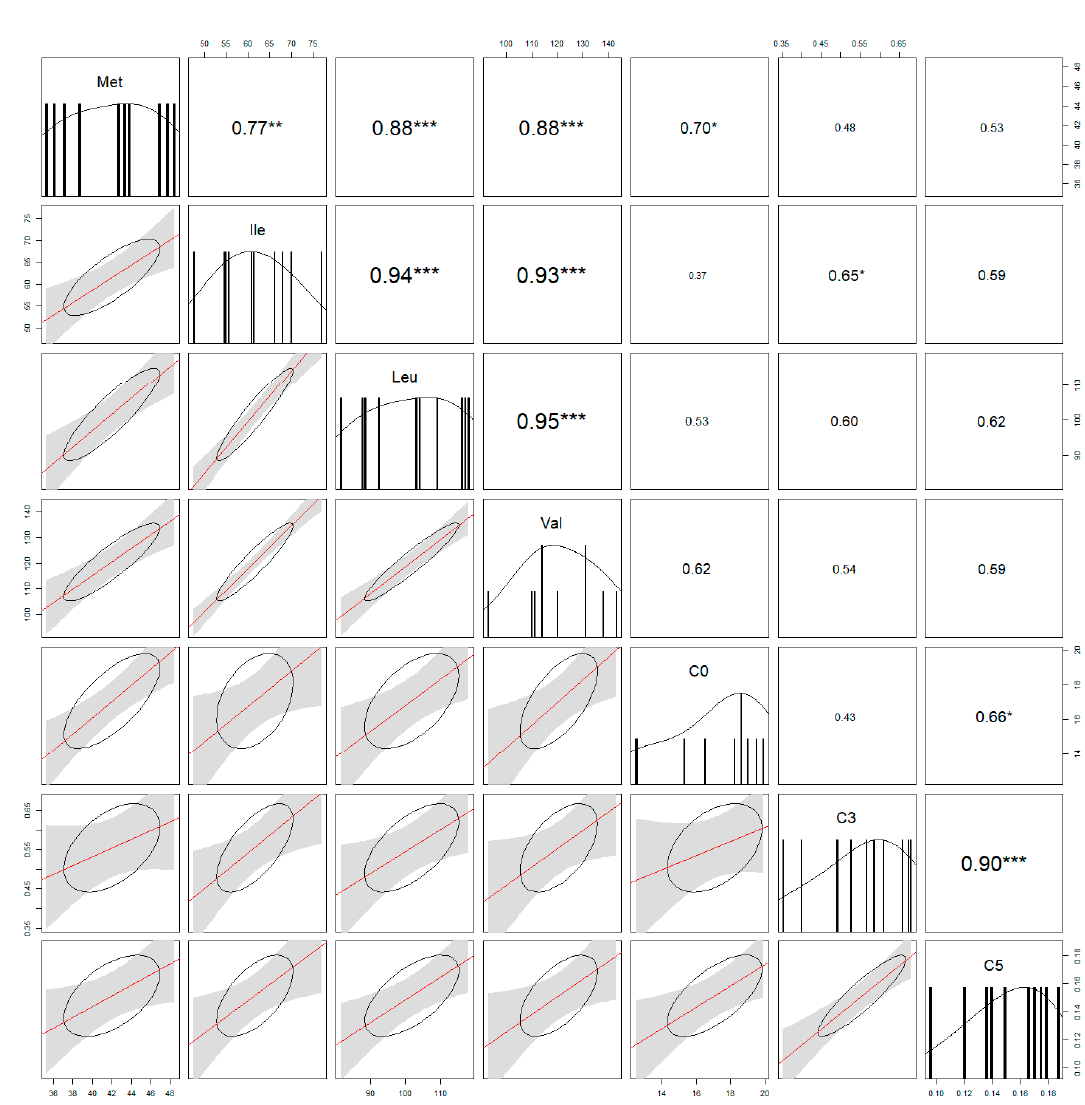
Figure 4. Analysis of correlations (correlograms) among levels of selected carnitines and amino acids in males ( A ) and females ( B ). The coefficients of Spearman Product Moment Correlation are reported. Significance is given by * p < 0.05, ** p < 0.01, and *** p < 0.001, respectively.